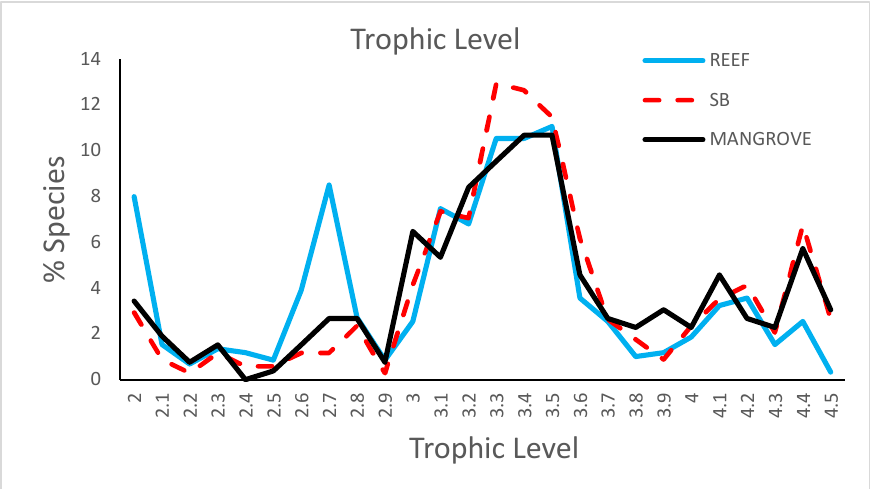
Figure 5. Trophic level spectra for the three habitats based on averages per diet class (see Section 2.2).